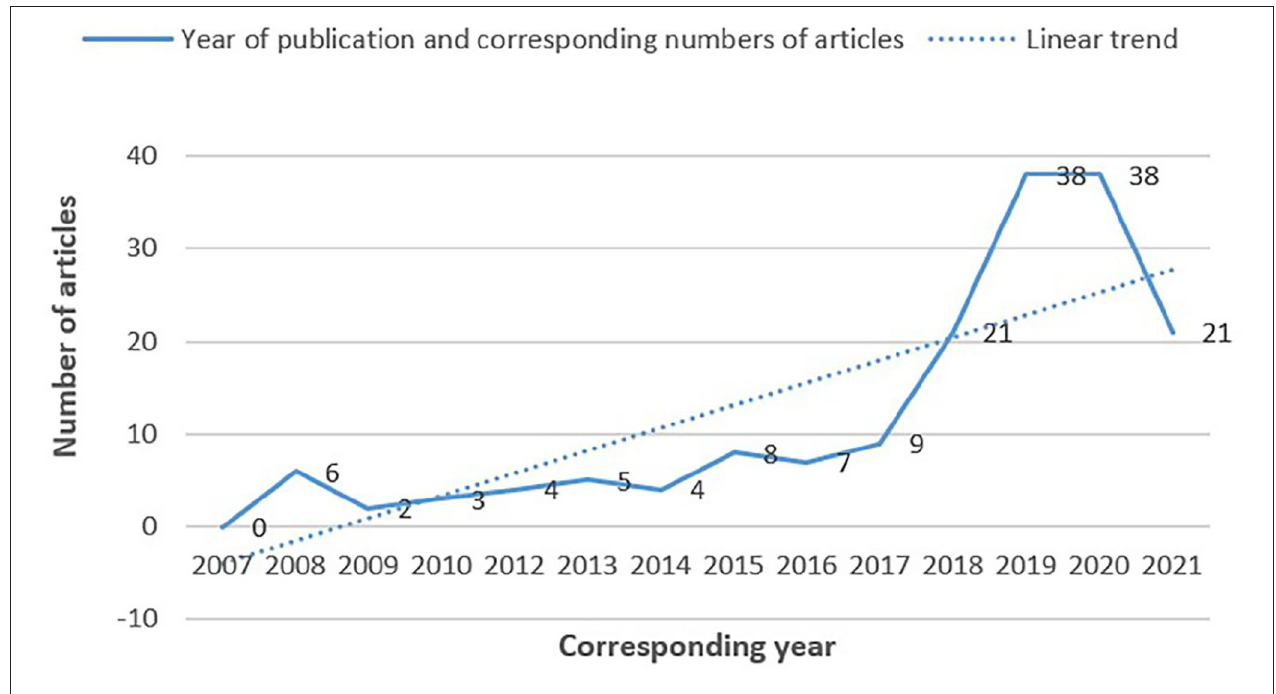
FIGURE 2 | The number of publications in different years